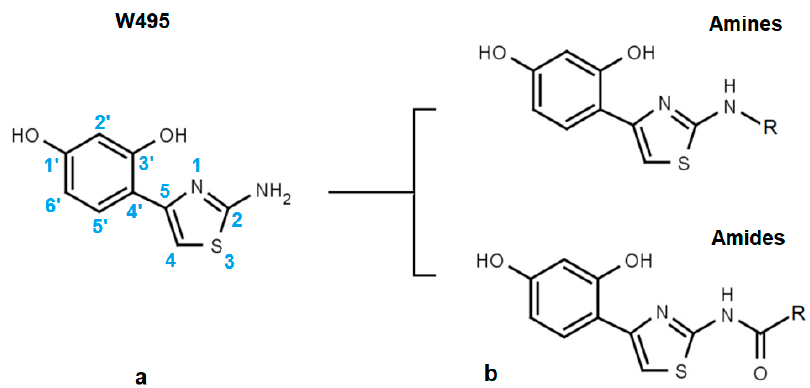
Figure 1. Basic structure of the resorcinyl thiazolamine inhibitors studied here is ( a ) the 4-(2-amino- 1,3-thiazol-4-yl) resorcinol moiety. ( b ) Derivatization of the primary amino group of the resorcinyl